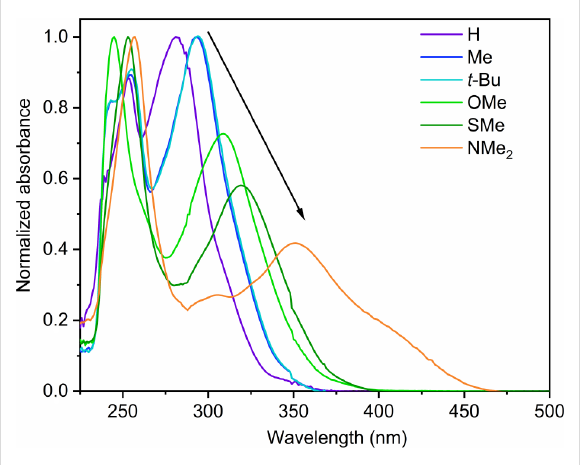
Figure 3: Normalized absorption spectra of the evaluated compounds in fluid THF at rt. All solutions were optically diluted (A < 0.1).